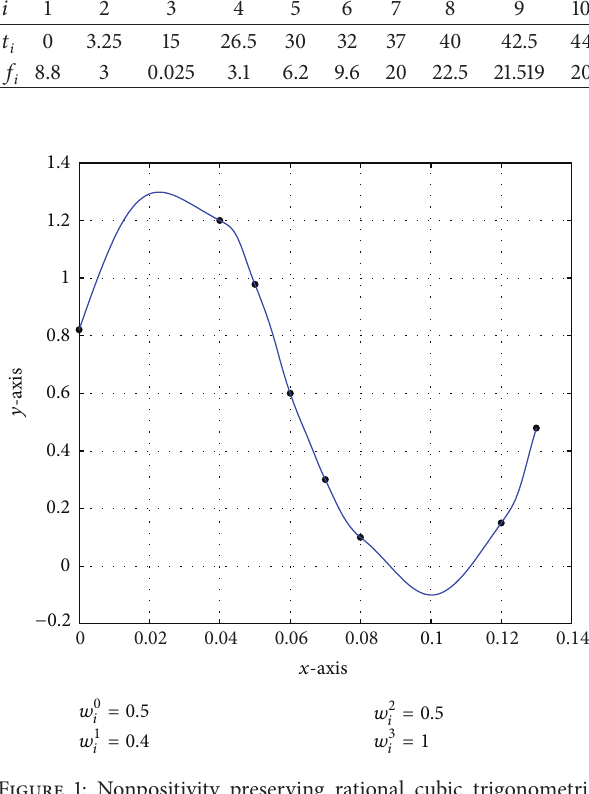
Figure 1: Nonpositivity preserving rational cubic trigonometric